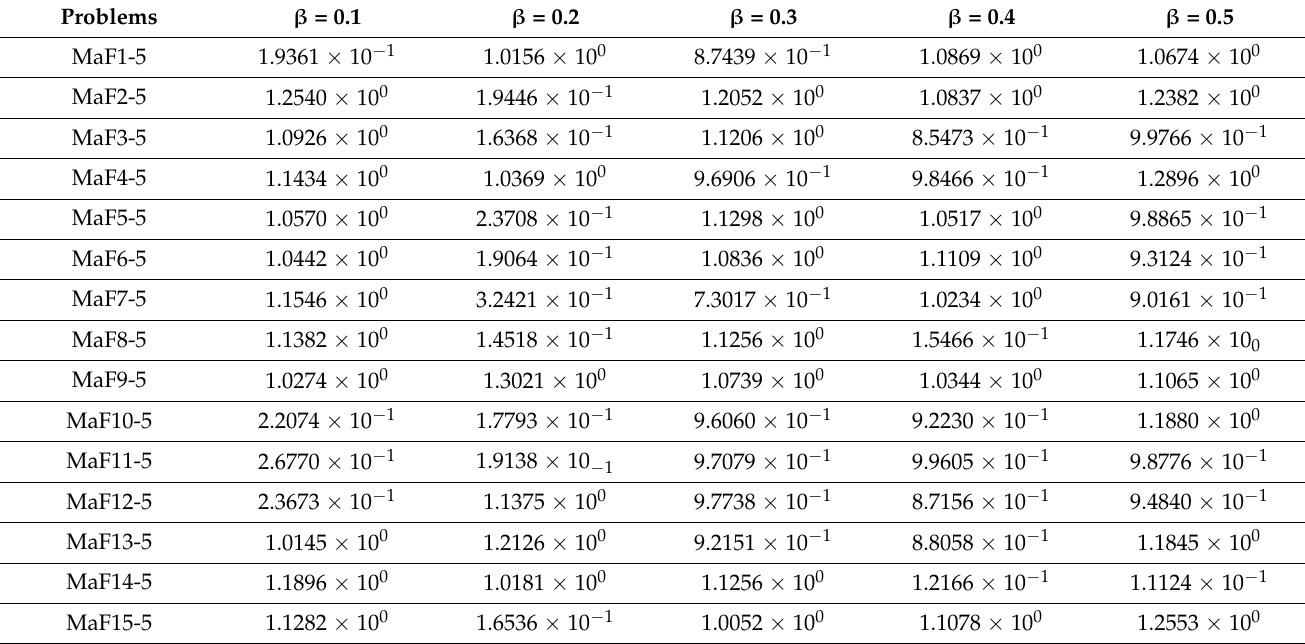
Table 3. IGD mean obtained by Two Arch-D with different β .